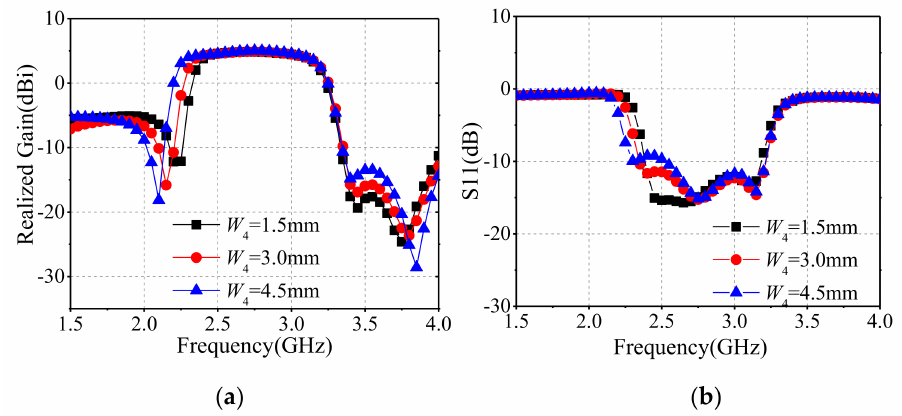
Figure 11. Simulated results for different parameter W 4 , ( a ) realized gain, ( b )